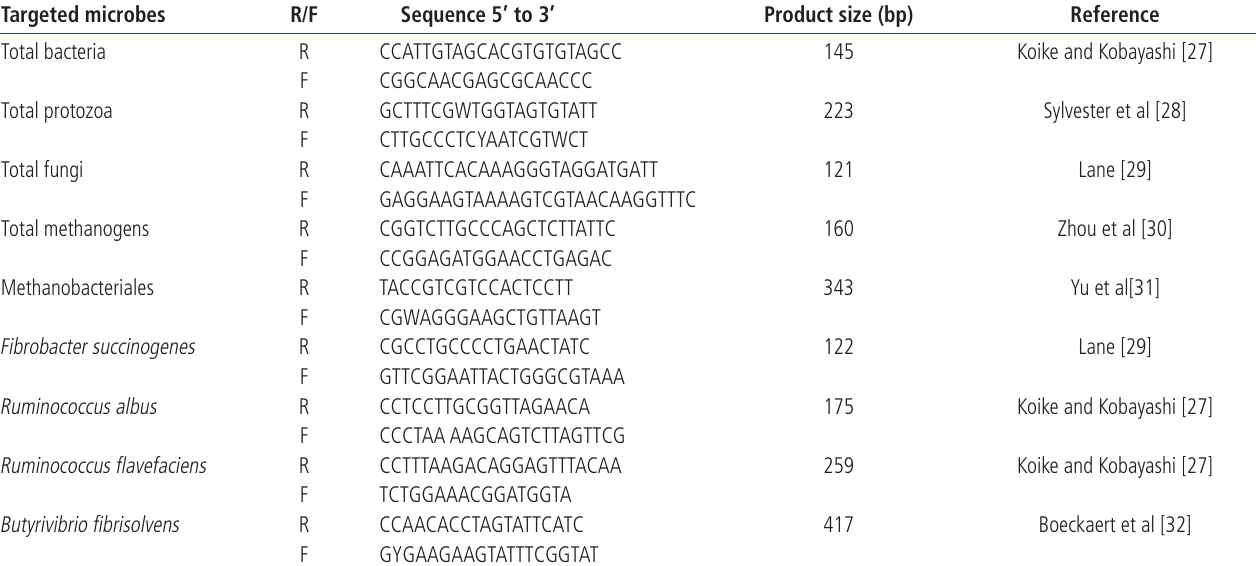
Table 2. Primers used for quantitative real-time polymerase chain reactions Targeted